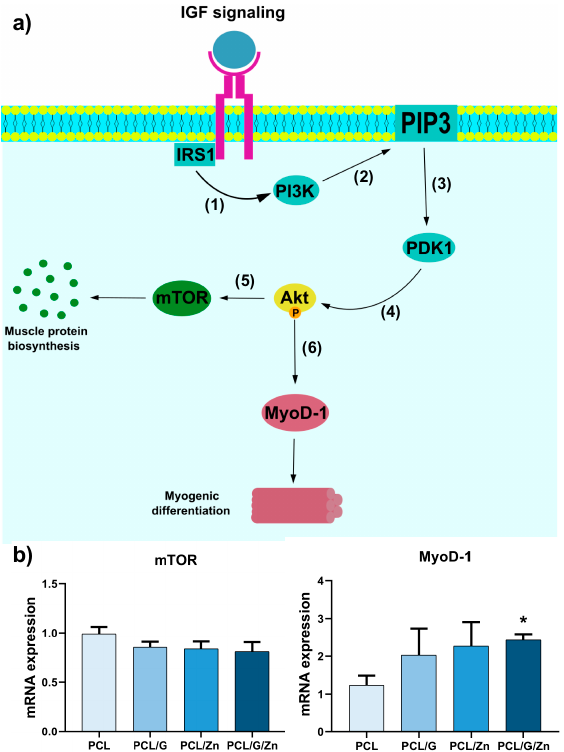
Figure 7. ( a ) Representative scheme of the simplified IGF/PI3K/Akt signaling pathway and its enrolment in muscle growth and myogenic differentiation. (1), (2) reference [40]; (3), (4) references [40,81]; (5) reference [73]; (6) reference [74]; ( b ) Gene expression analysis results (RT-qPCR) for mTOR and MyoD-1 after culture in serum-deprived medium (DMEM +2% FBS +1% P/S) with GAPDH as housekeeping gene. (*) p < 0.05 between PCL and PCL/G/Zn conditions.